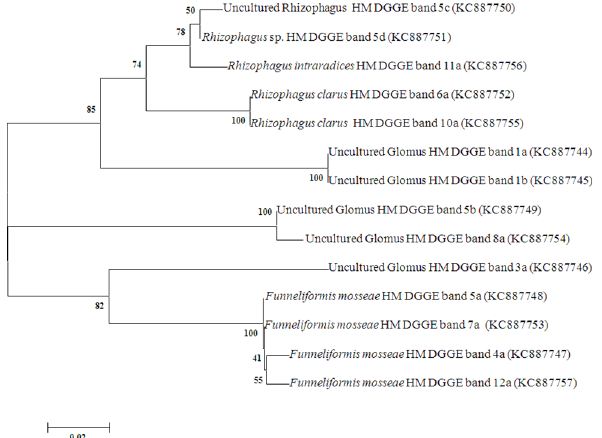
Fig 4. Nearest BLAST match name of the dominant Glomeraceae sequences obtained from DGGE gel.